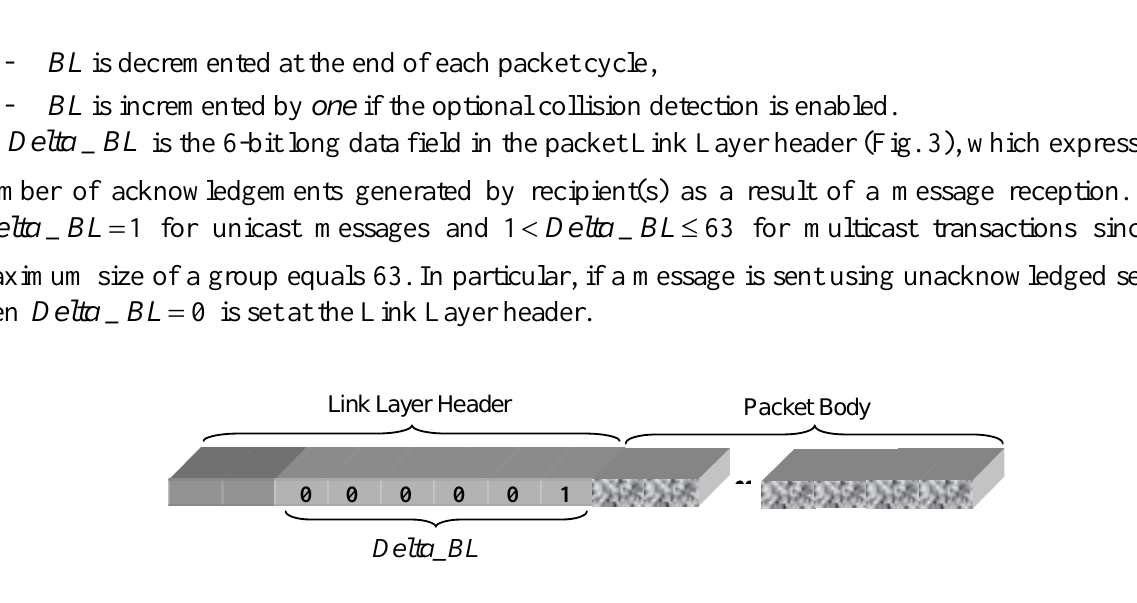
Figure 3. BLDelta _ is the 6-bit long data field in the 8-bit Link Layer